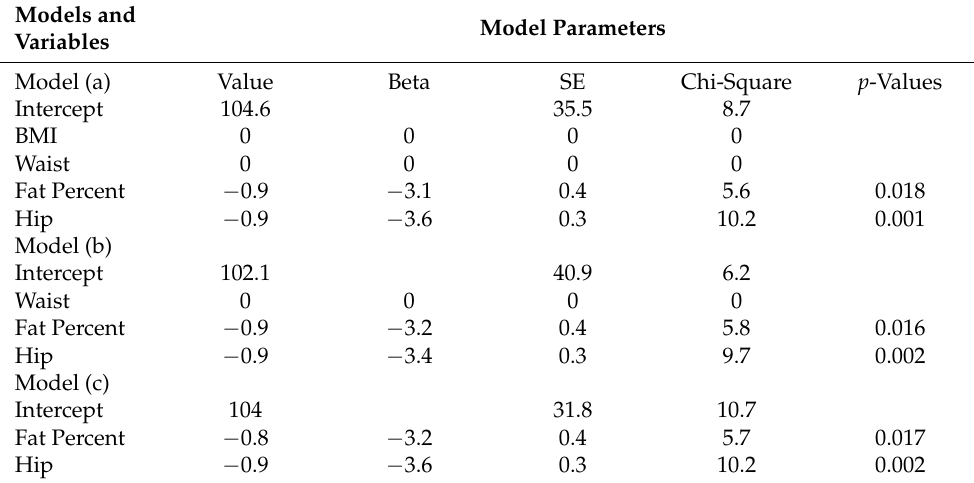
Table 6. The contributions of the variables to the LR model’s